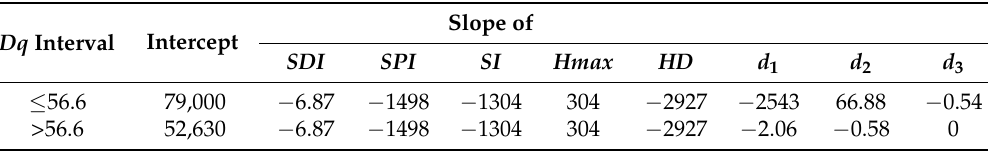
Table A2. The parameters of the approximation to the deterministic part of the NFI-based model (see Section 2.3 and Equation (A3)) that substitutes s ( Dq ) by two polynomials; the intercept implies that of the polynomial approximation and thus depends on the interval of Dq